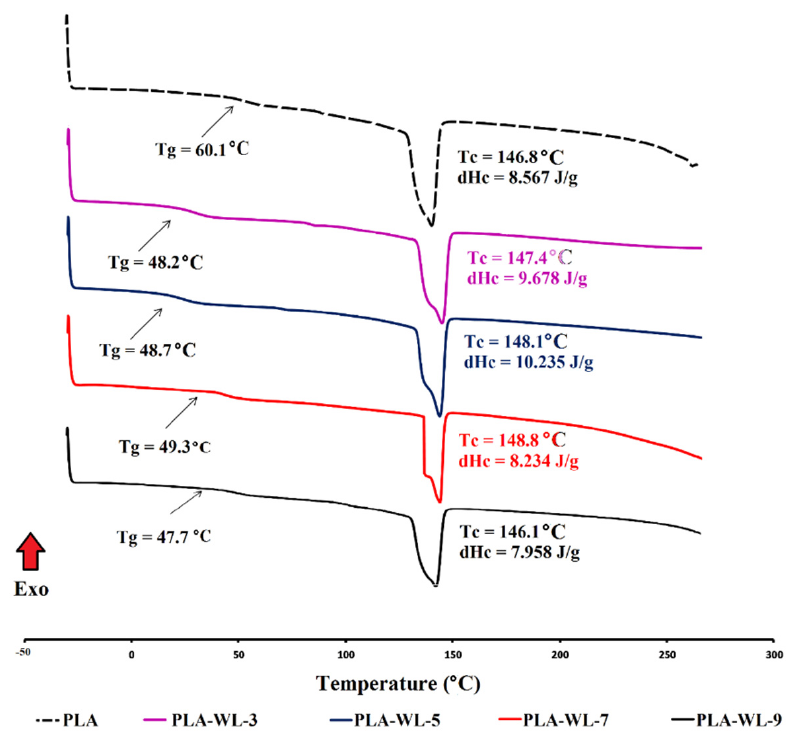
Figure 4. The DSC curves for PLA ‐ WL biocomposites.